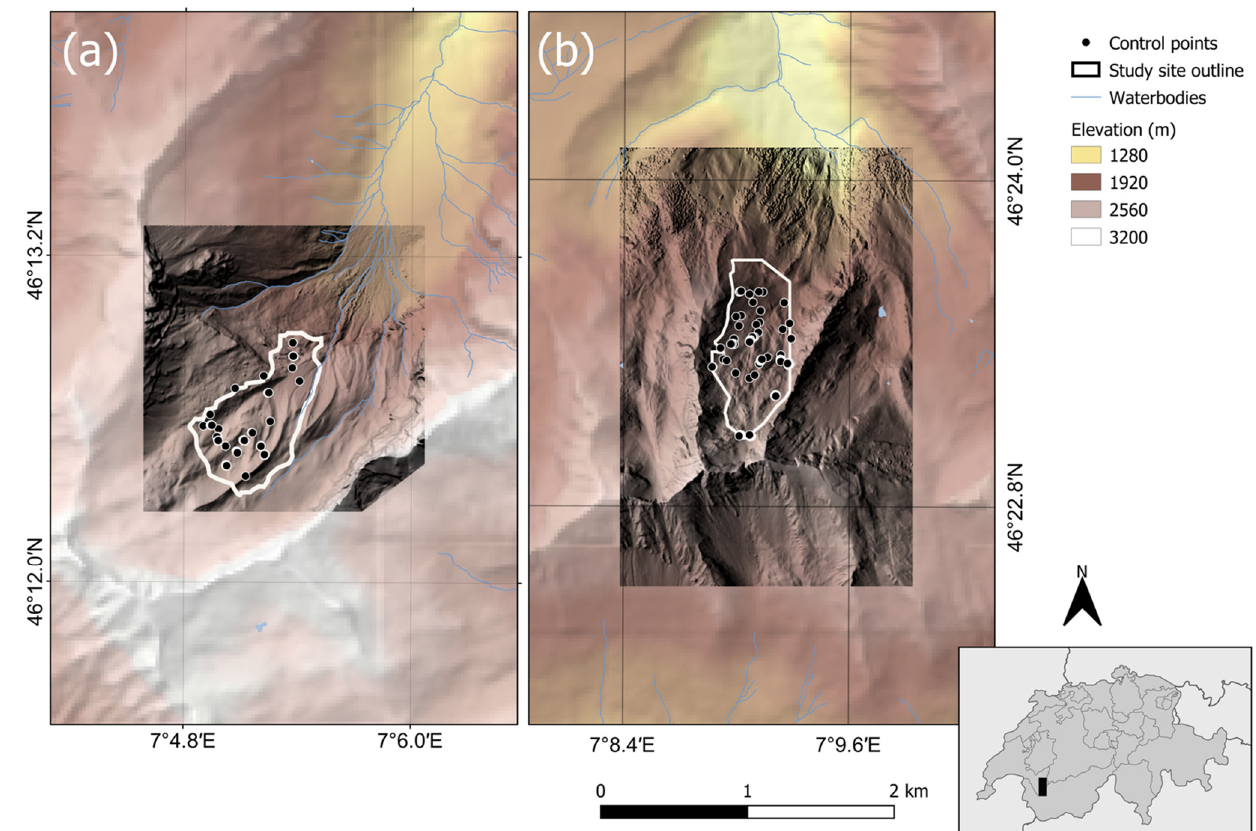
Figure 1. Location of ( a ) Martinets and ( b ) Para study sites in the western Swiss Alps (location indicated in black rectangle on the Swiss map insert). The site perimeter is outlined in white and geo-referenced points are indicated as black dots. The Light Detection and Ranging (LiDAR) digital elevation models (DEMs) are superimposed on an elevation map of the surrounding area and are in darker colors. Table 1. Location and characterization of the two study sites, Martinets and Para, situated in valleys in the western Swiss Alps, including the areas of the target study sites and DEM extents, as well as the number of geo-referenced points used in the analyses.